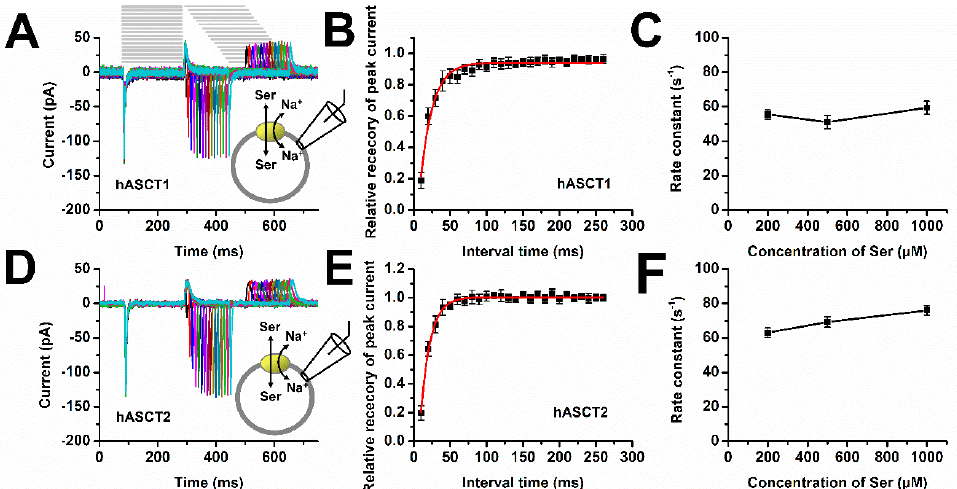
Figure 6. Paired-pulse experiment reveals recovery time constant after substrate removal. Paired- pulse experiments were performed with 140 mM NaMes and 200, 500, or 1000 µ M serine in the extracellular solution and with 130 mM NaMes and 10 mM serine in the pipet solution. ( A , D ) Typical set of currents with an increase of recovery time of 10 ms in each trace (the bars at the top show the solution change protocol) at 500 µ M serine. Peak amplitudes from ( A , B ) recovery currents were fitted using a single-exponential function (I = I 0 (1 − exp( − kt)) ( B ), ASCT1 and ( E ) ASCT2, yielding recovery rate constants of 60 ± 4 s − 1 ( B ) and 75 ± 3 s − 1 ( E ). The recovery rate constant was independent of the extracellular serine concentration for both ASCT1 ( C ) and 2 ( F